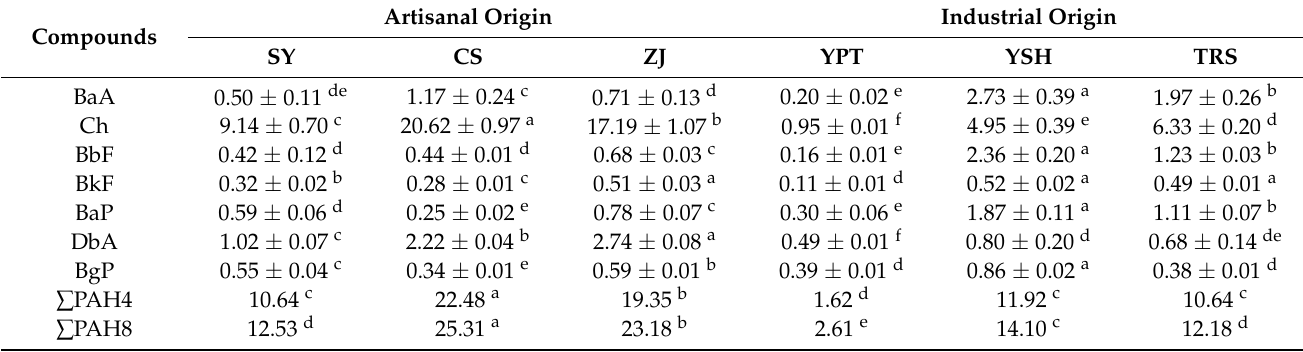
Table 3. Content of polycyclic aromatic hydrocarbons ( µ g/kg) in Larou of artisanal and industrial origin.